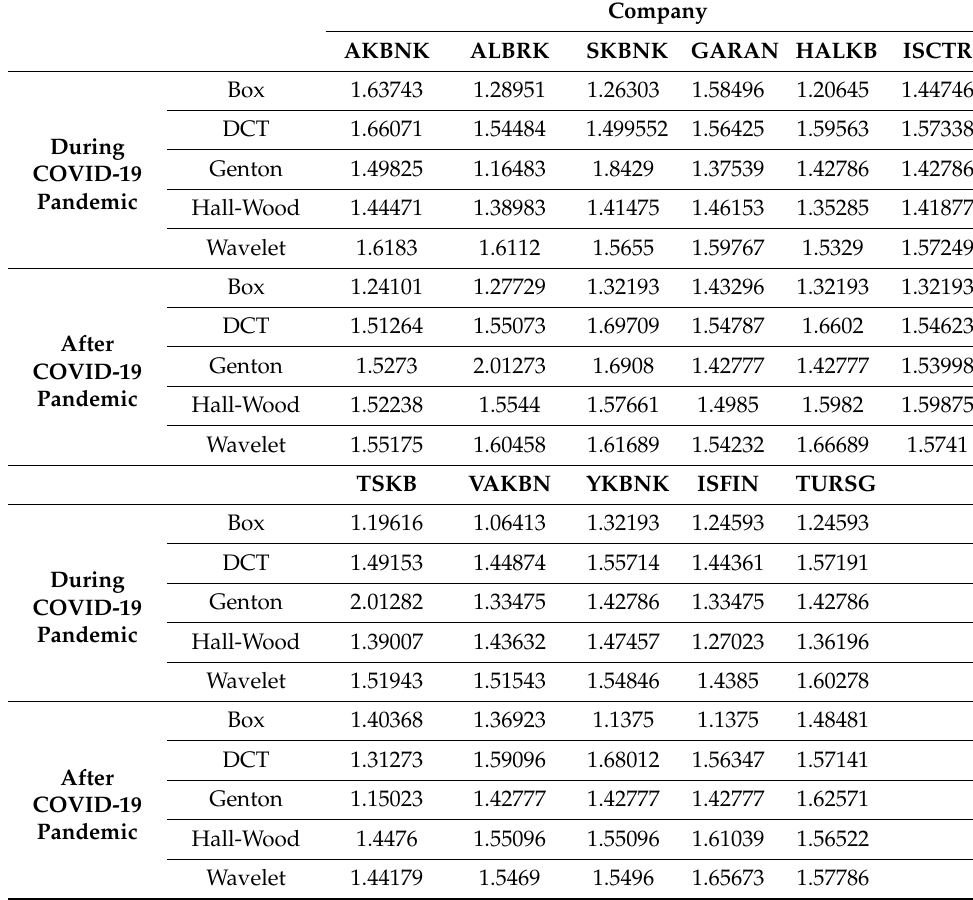
Table A10. Fractal dimensions for the financial services